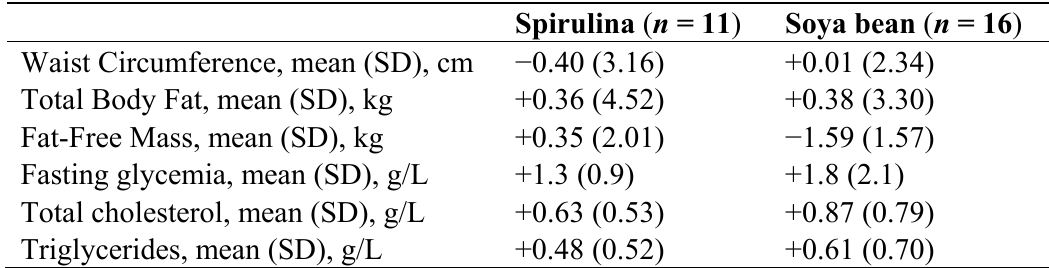
Table 3. Change of other characteristics from